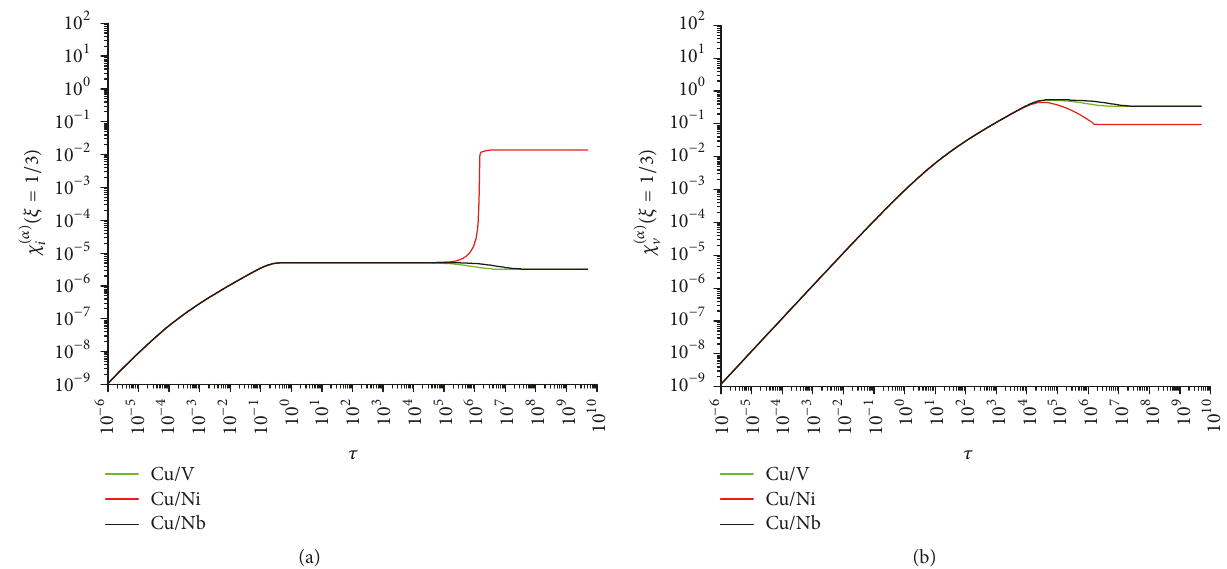
Figure 7: Temporal profiles of (a) SIA and (b) vacancy concentration in layer 𝛼 at the interface between metals 𝛼 and 𝛽 .